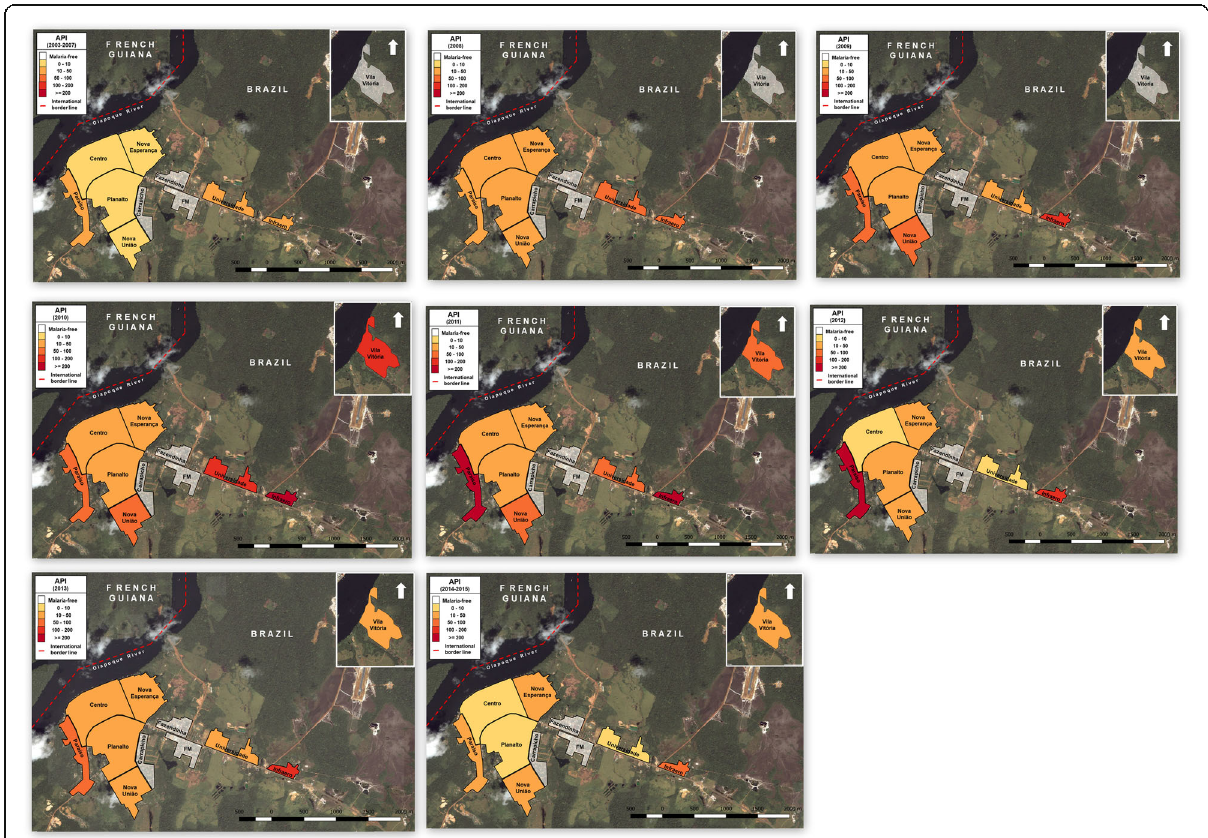
Fig. 3 Spatial distribution of the incidence of malaria in the urban areas of the municipality of Oiapoque between 2003 and 2015. Source: Sivep-Malaria